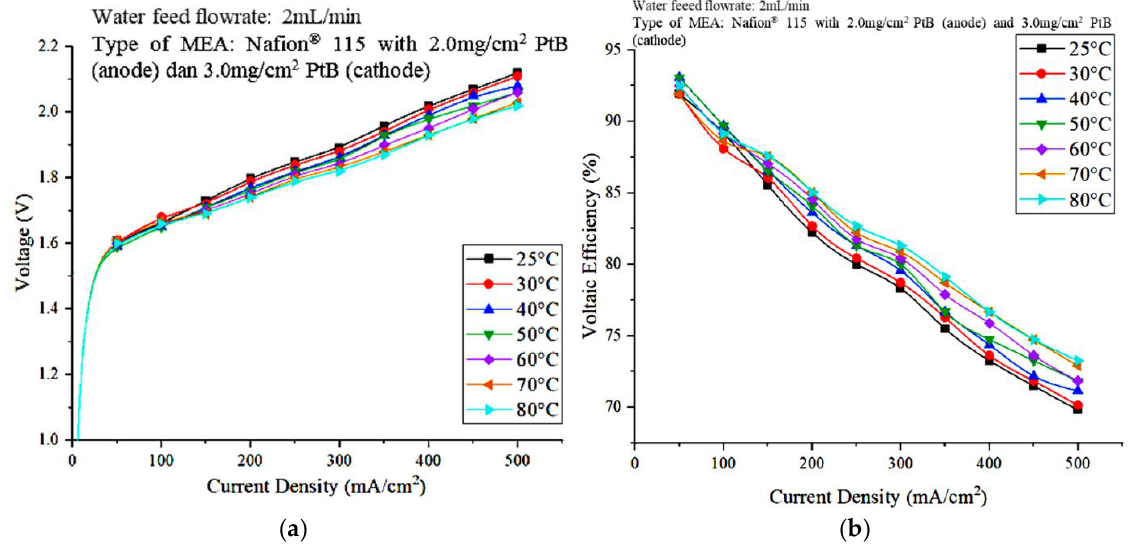
Figure 7. Effect of the operating temperature on PEM electrolyzer performance ( a ) Polarization curves ( b ) Voltaic efficiency